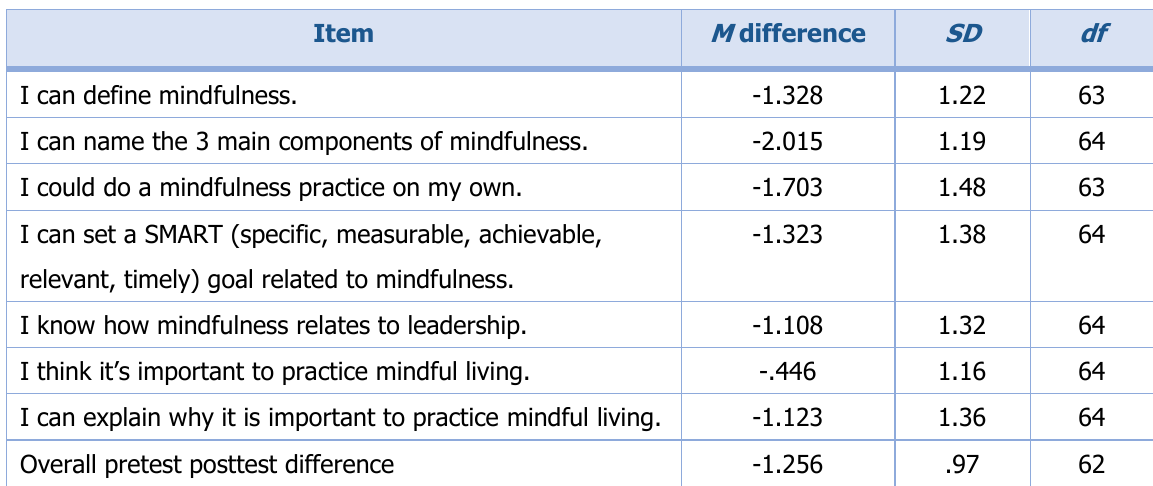
Table 5. Paired Samples T-Test Results for Perceived Knowledge of Mindfulness Item